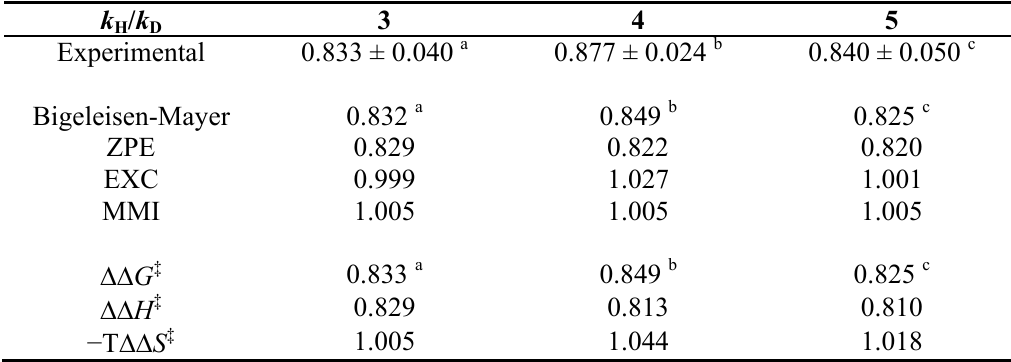
Table 1. KIEs for compounds 3 – 5 using scaled B3LYP/6-31G(d,p) harmonic frequencies via the Bigeleisen-Mayer or  H  S